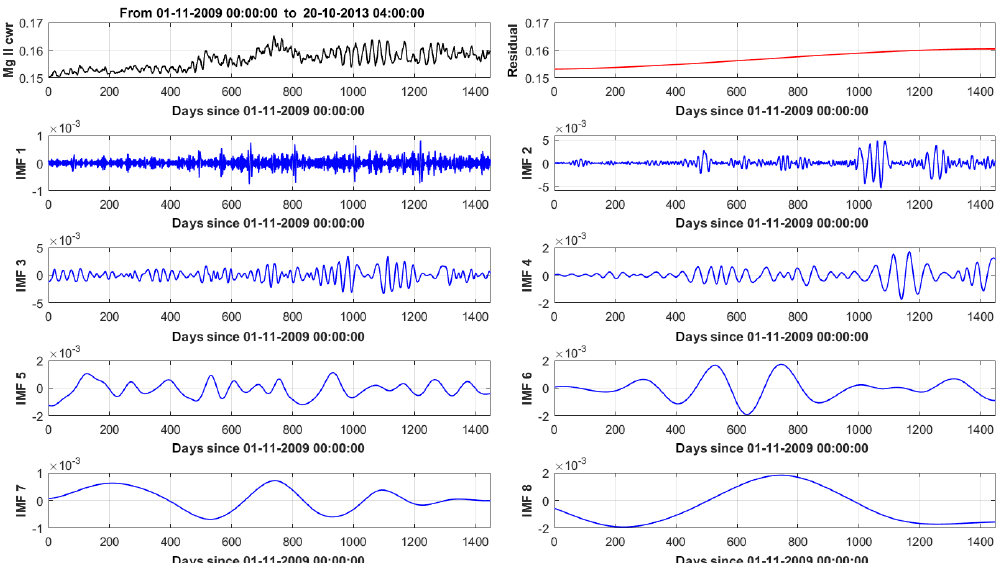
Figure 9. EMD decomposition for the Mg II solar UV flux proxy. Top row: original signal and trend. From first row: successive orders of basis functions